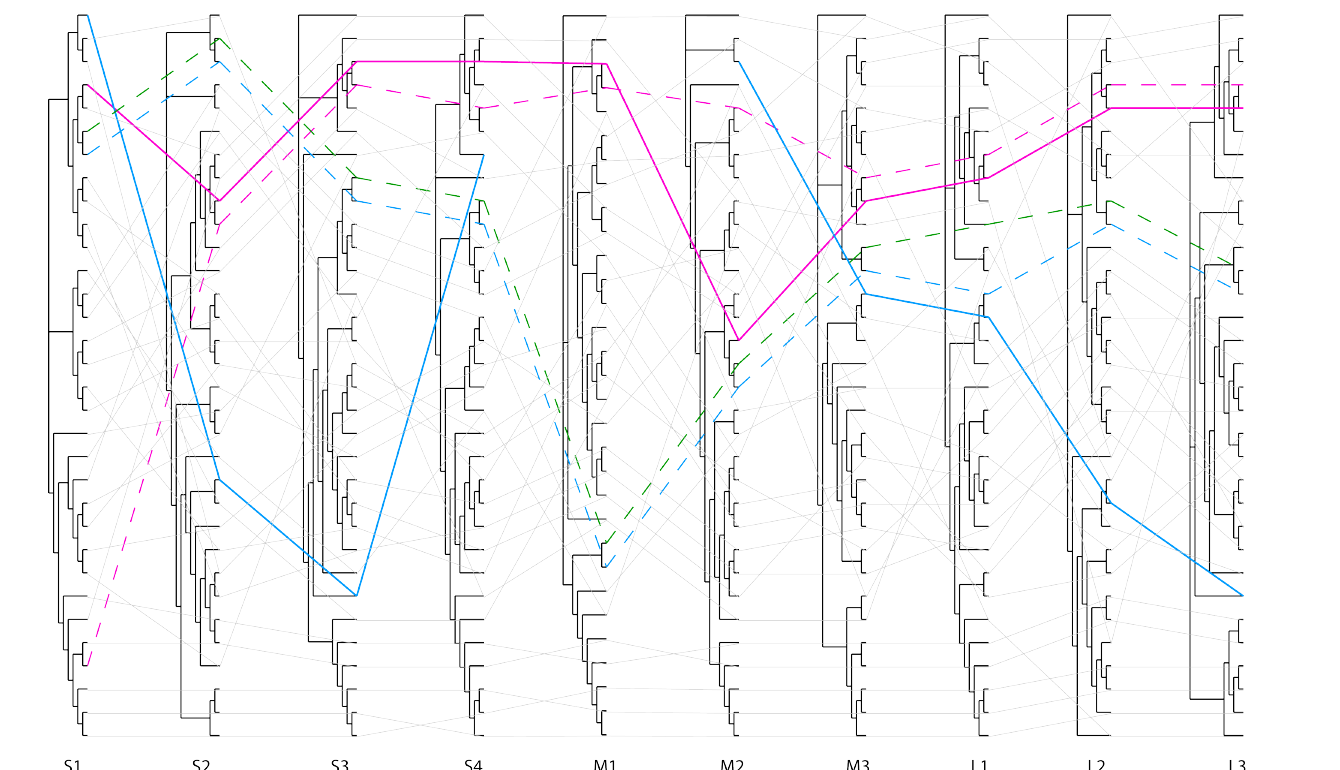
Figure 5. Graphical reassortment analysis using tanglegrams to explore the phylogenetic congruence between the 10 segments of MRVs. The figure shows the strong phylogenetic correlation across most of the genome between MRV strains found in pigs from farm 1, shown with full and dashed fuchsia lines, with incongruent phylogeny supporting reassortment in S1, S4 and M2 segments. The figure also indicates strains the most likely parental strains for S1 and M2 found in a myotis bat (blue dashed line) and a vole (green dashed line). Finally, the figure highlights how pig strains have different evolutionary origin than the MRV isolated from a myotis bat roosting in the same environment, shown as a full blue line. M1 is not shown as no reads were obtained from the bat’s